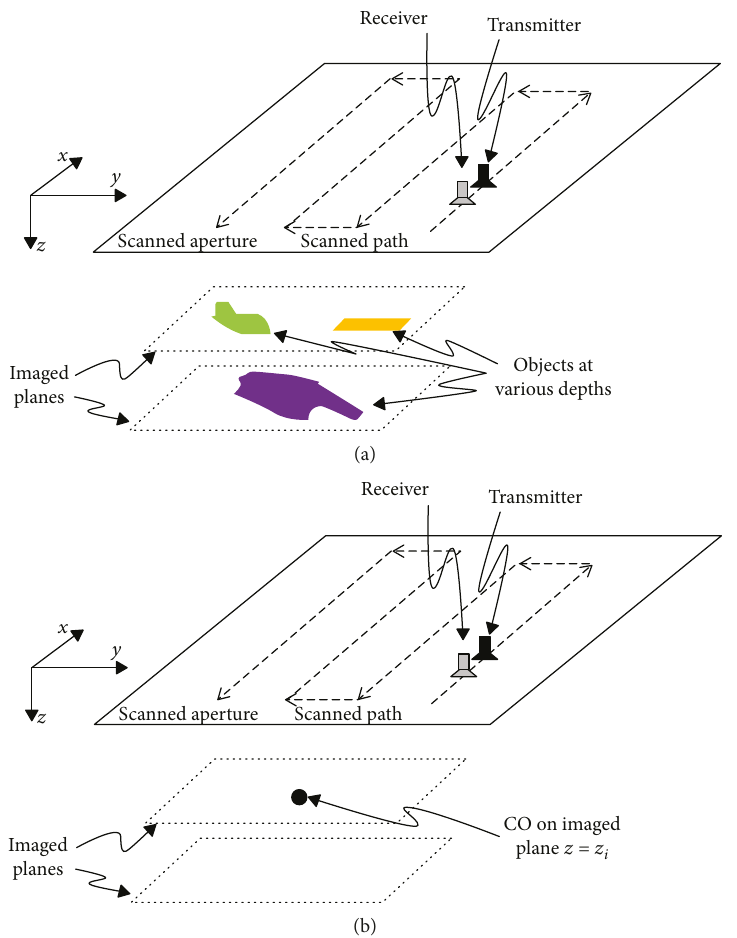
Figure 1: (a) Illustration of a wideband 3D microwave holographic imaging setup that consists of a transmitter antenna and a receiver antenna that move together to scan a rectangular aperture. (b) Illustration of placing a CO on the imaged plane z = z x , y , f corresponding to that plane, that is, E sc,co z i